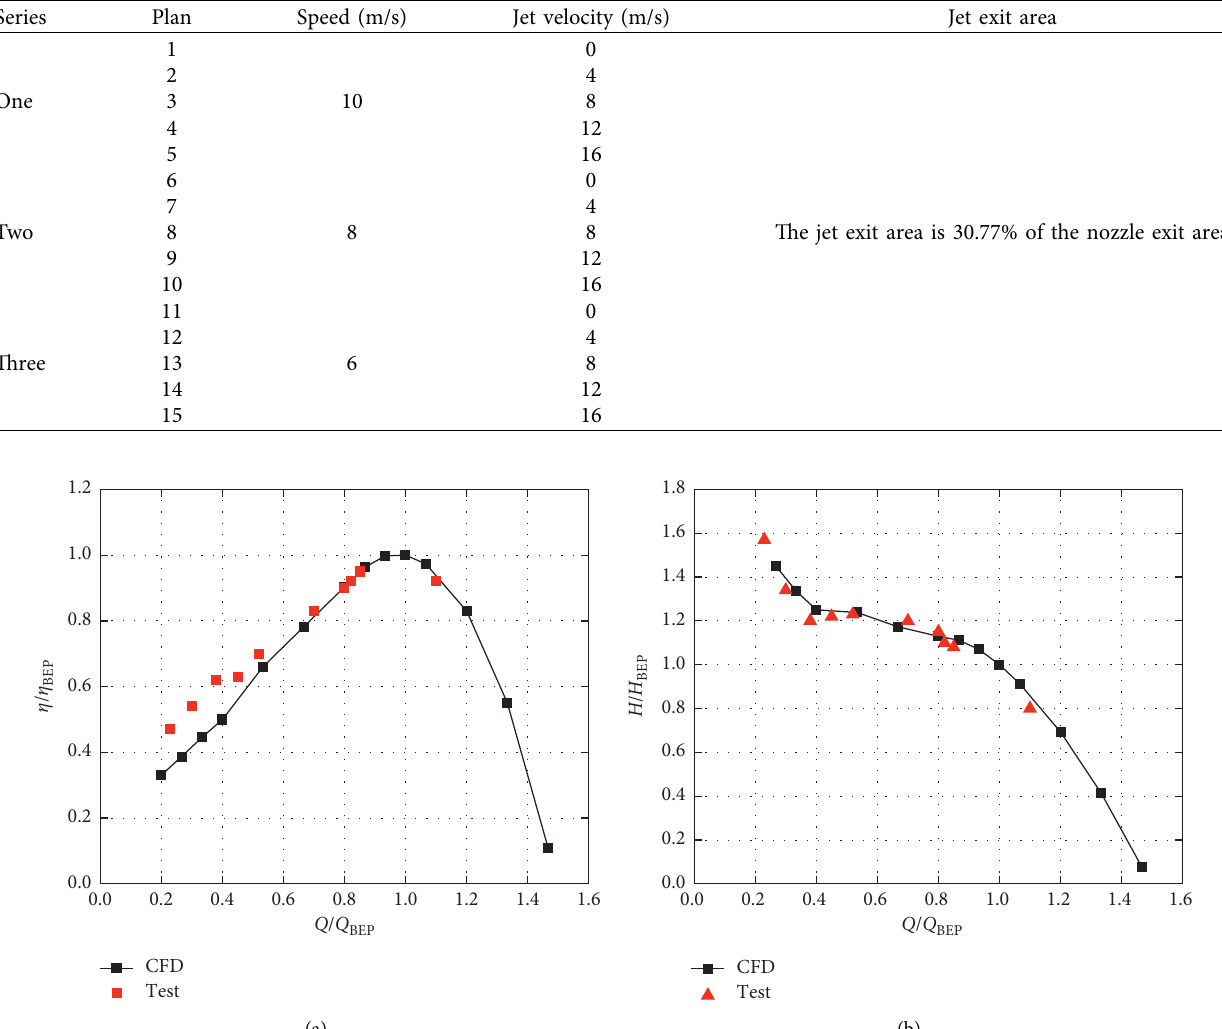
Table 2: Research plan.